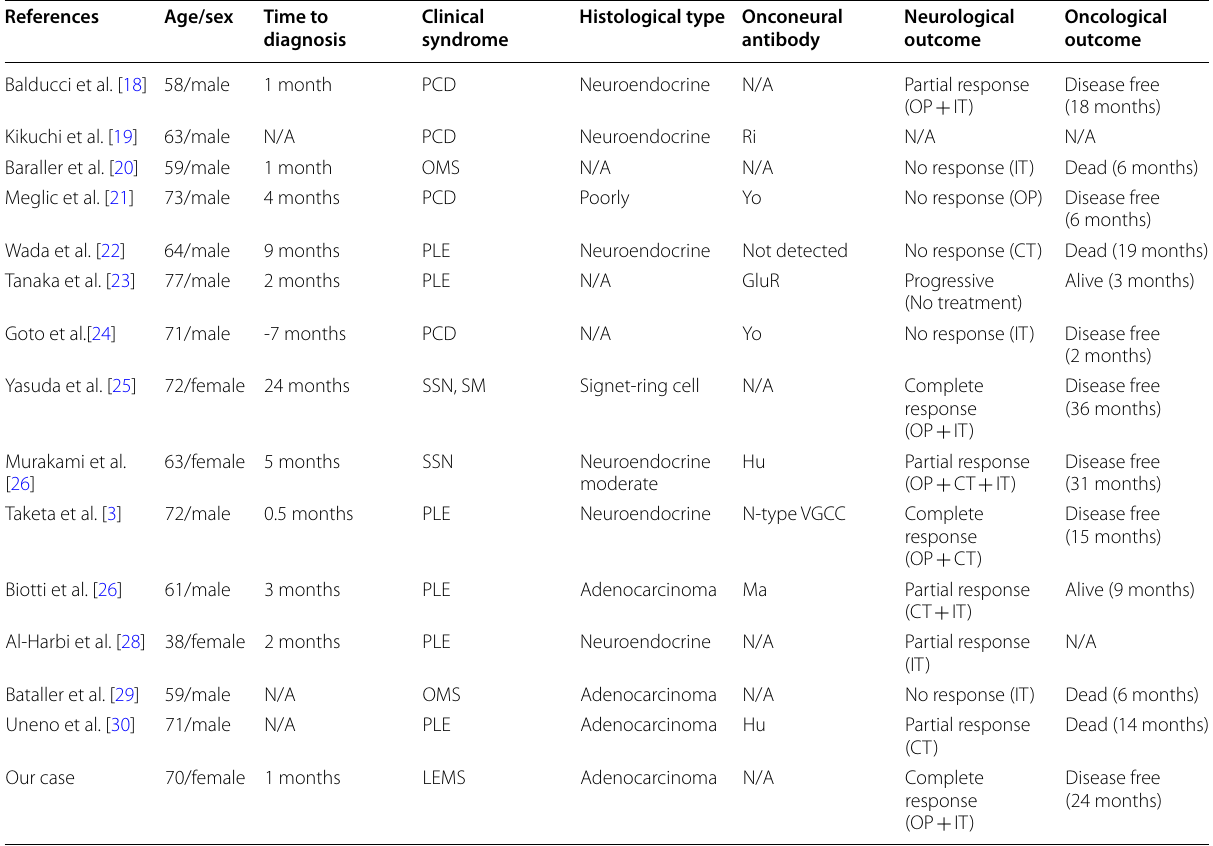
Table 1 Description of case studies from the literature